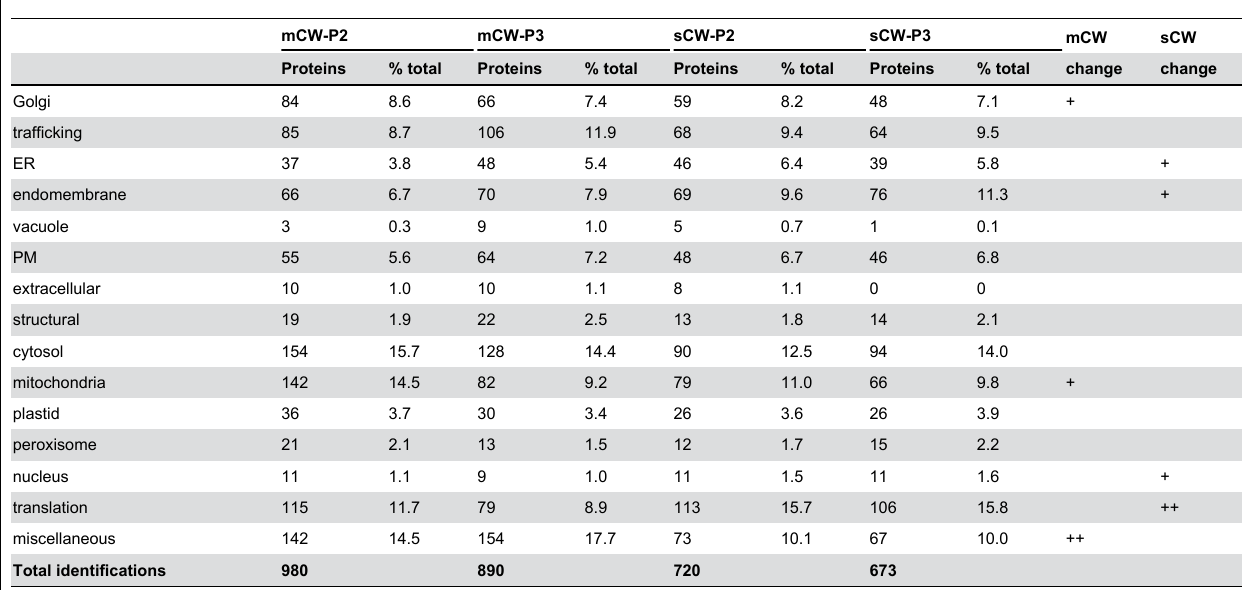
Table 4. Normalized protein counts highlighting changes in subcellular localization composition in samples mCW and